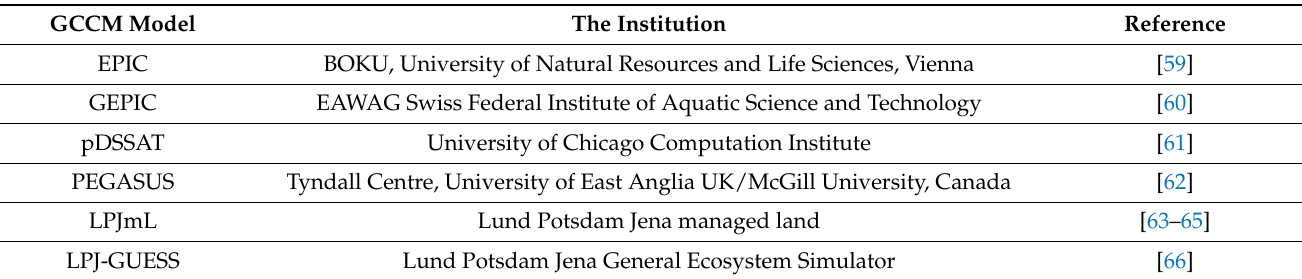
Table 1. The GCCM global crop climate models and their sources.